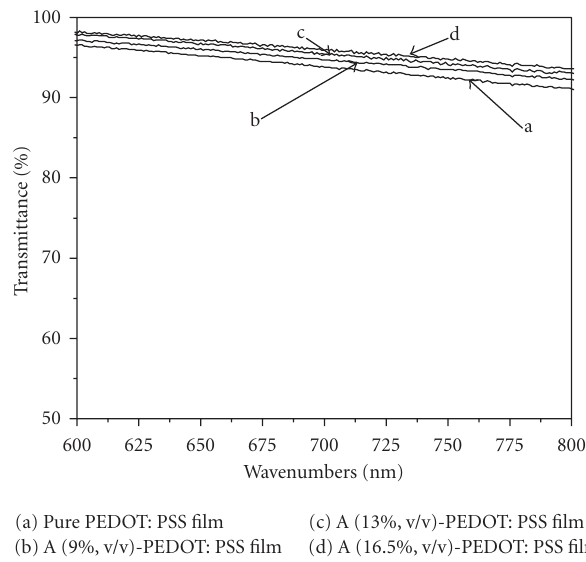
Figure 5: The optical transmittance of PEDOT:PSS films as a function of doping ratio of